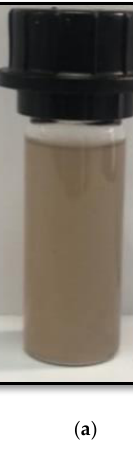
Figure 27. Wastewater discoloration produced by the coagulation treatment: ( a ) Raw FW; ( b ) FW after coagulation treatment using the LC biocoagulant.